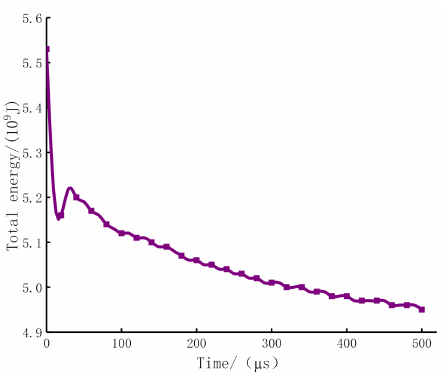
Figure 4. Energy variation curve of single-hole